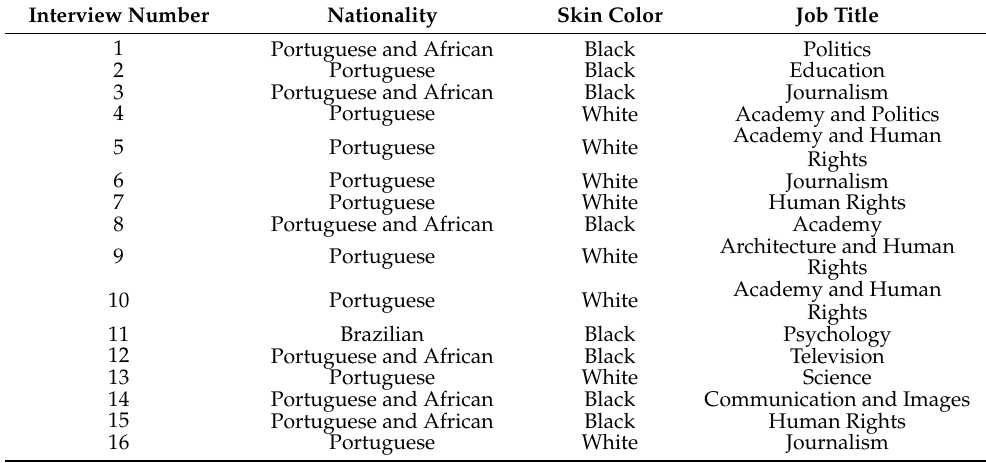
Table 1. Characterization of the interviewee nationalities, skin colors, and professional